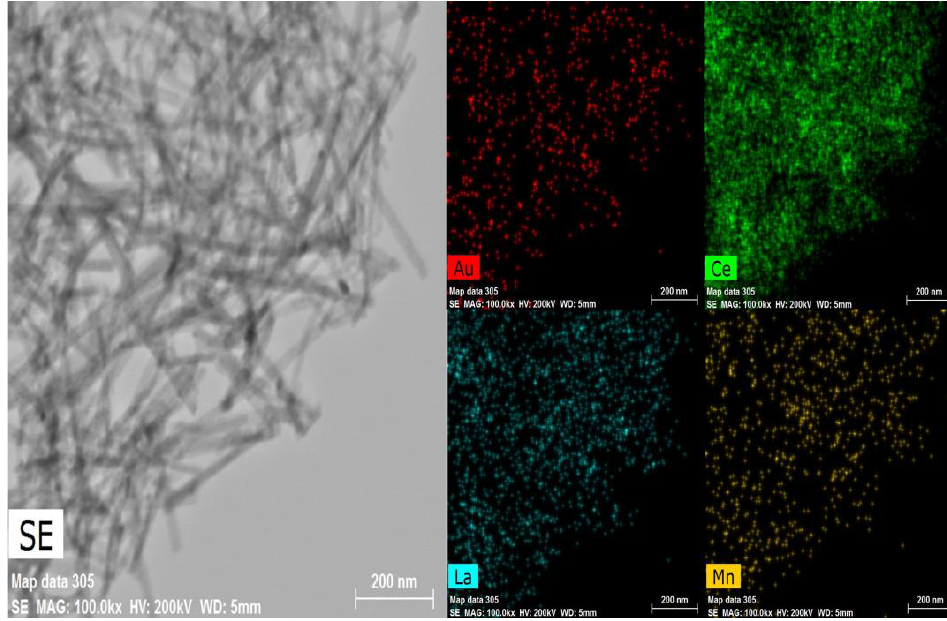
Figure 3. STEM - EDS maps of the Au/CML catalyst . Figure 3. STEM-EDS maps of the Au/CML